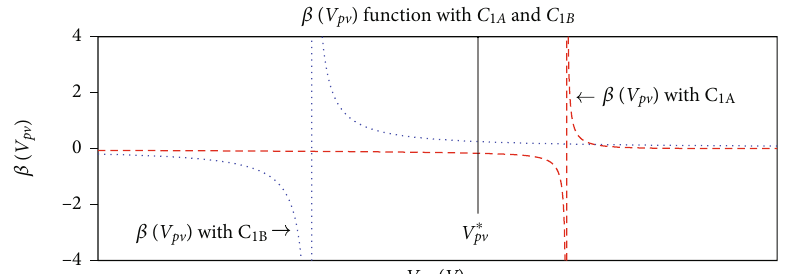
Figure 3: Behaviour of the function β ð v